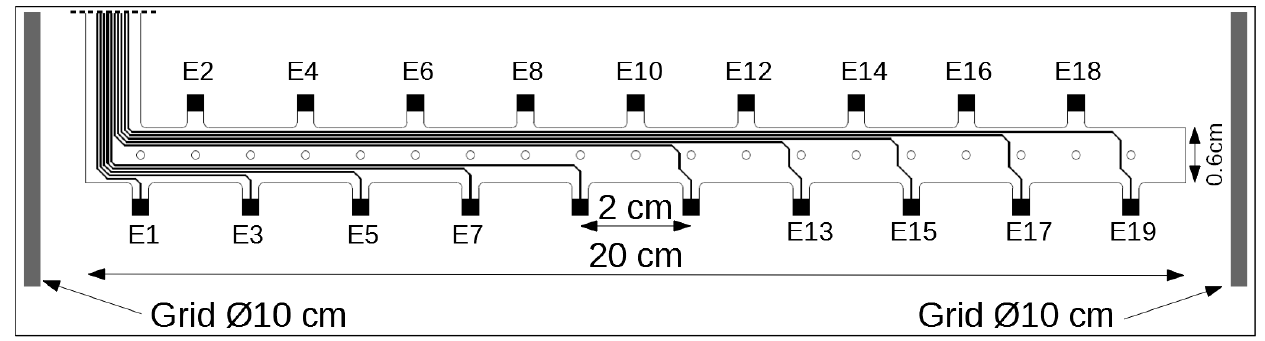
Figure 1. Schematic diagram of the PCB sensor with 19 electrodes (E1 to